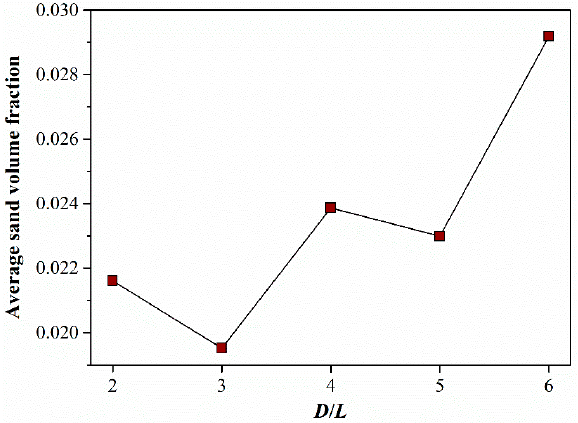
Figure 11. Averaged sand volume fractions over the pump inlet section.